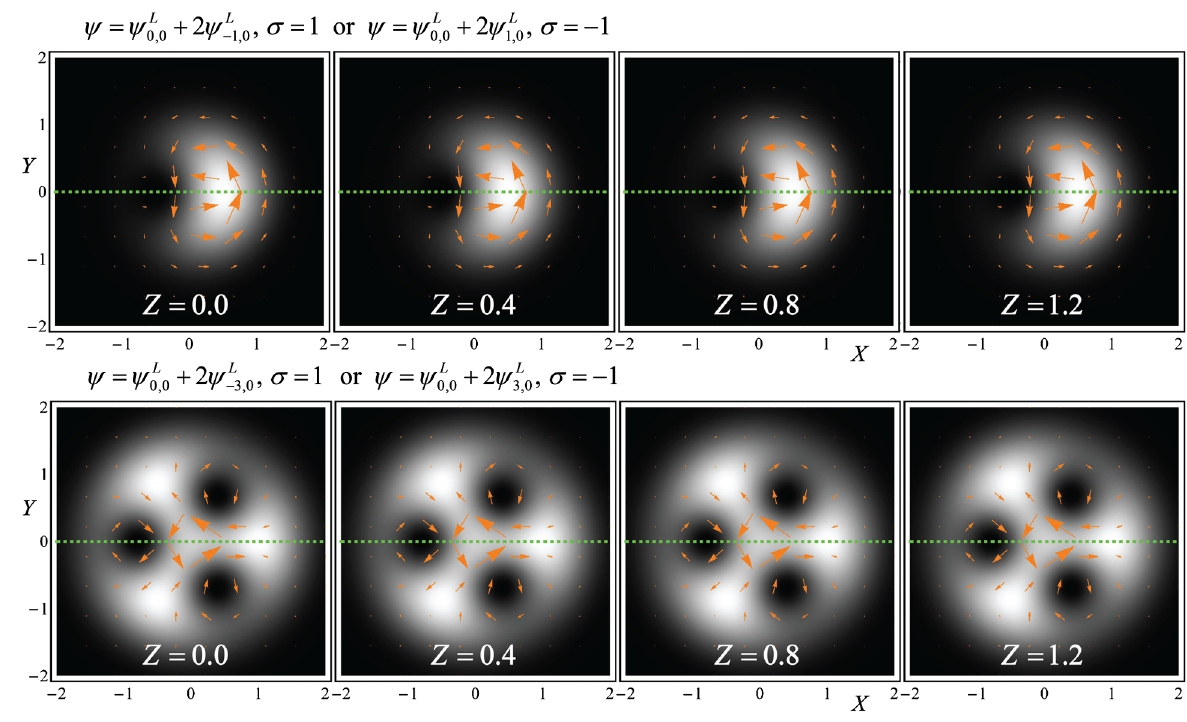
FIG. 8. Same as in Fig. 7, but for opposite vortex charges ‘ ¼ (cid:1) 1 and ‘ ¼ (cid:1) 3 (or opposite magnetic field, (cid:8) ¼ (cid:1) 1 ). Propagation without rotation corresponds to Eq. (41b) and is explained by the cancellation of the transverse-current contributions from the vortex (see Fig. 9). exp ð i‘’ Þ and from the vector-potential A ’